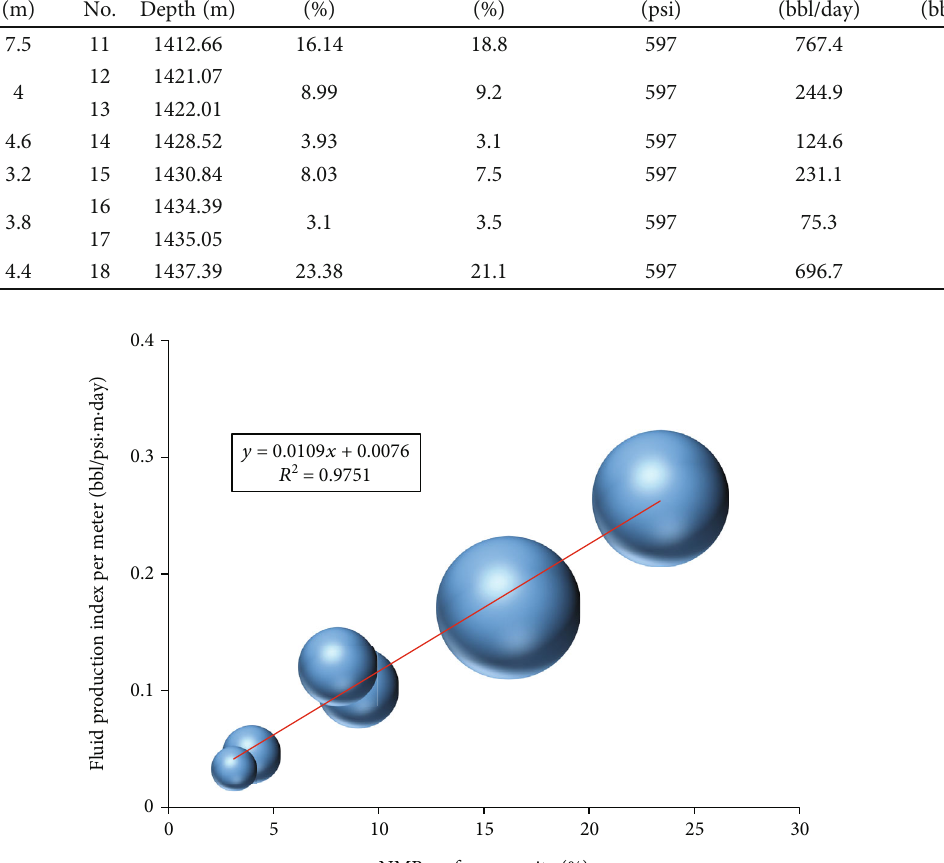
Producing Fluid production Production split pressure drop index per meter